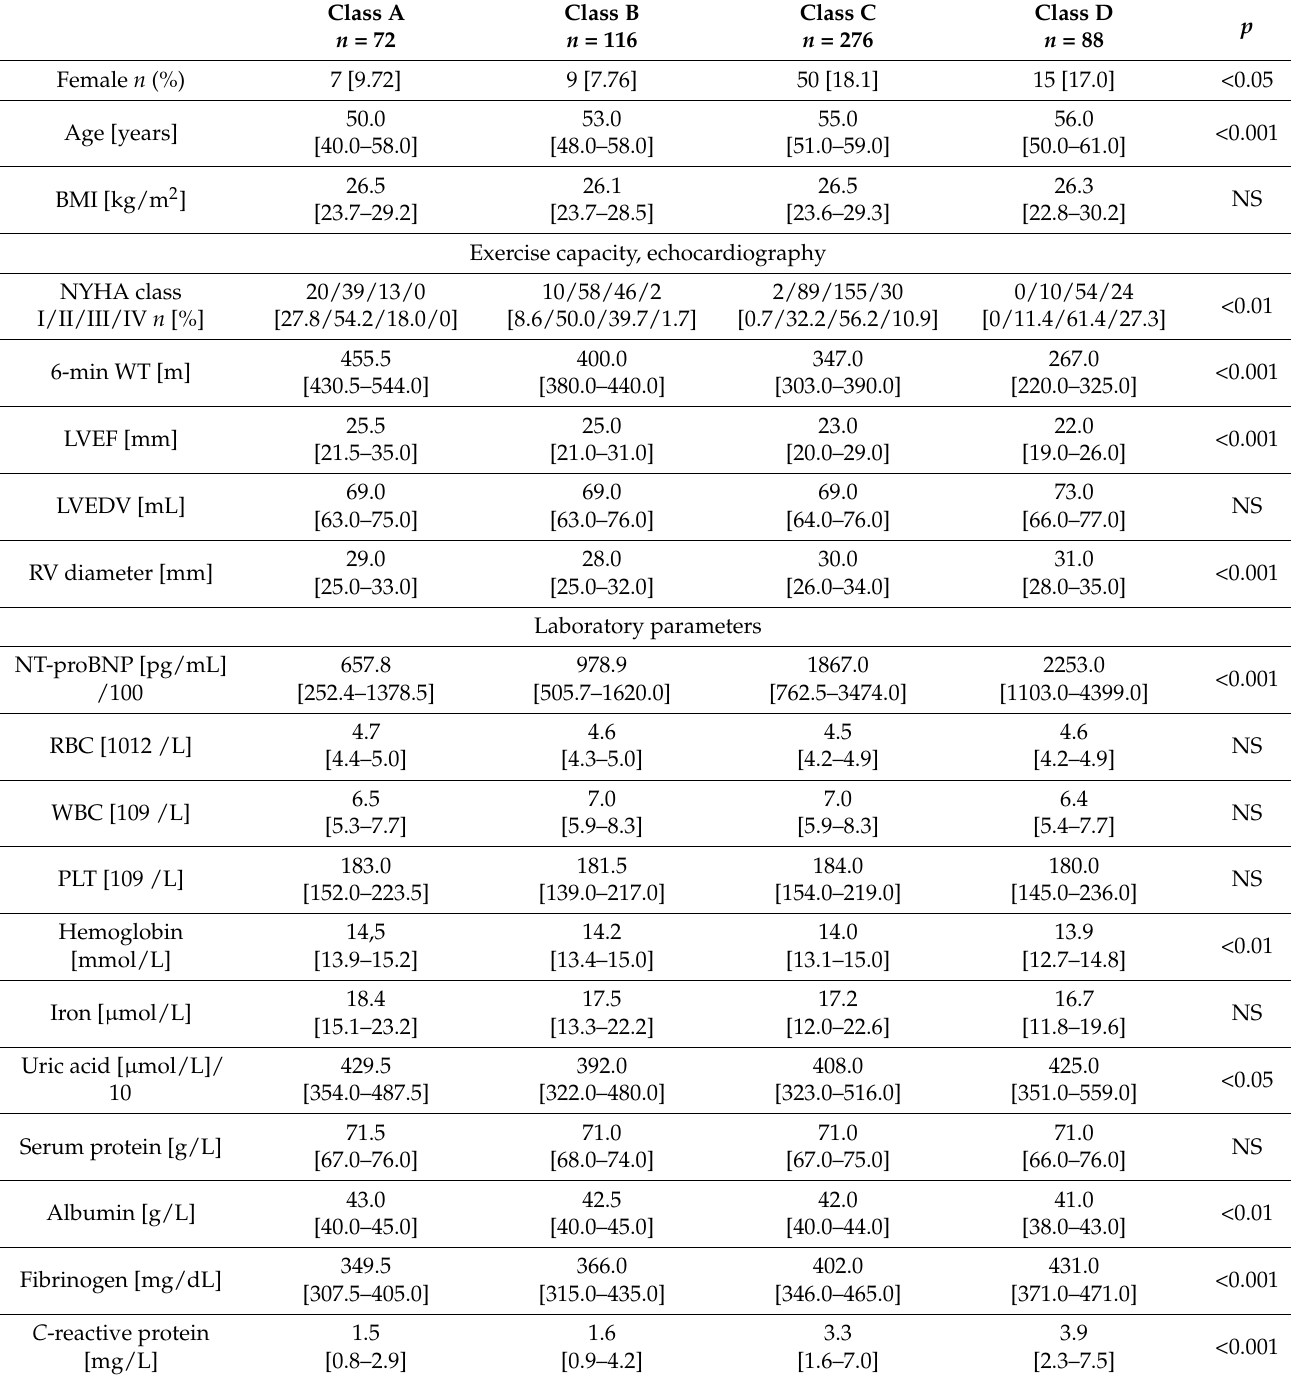
Table 1. The characteristics of the patients in the individual subgroups depending on the Weber